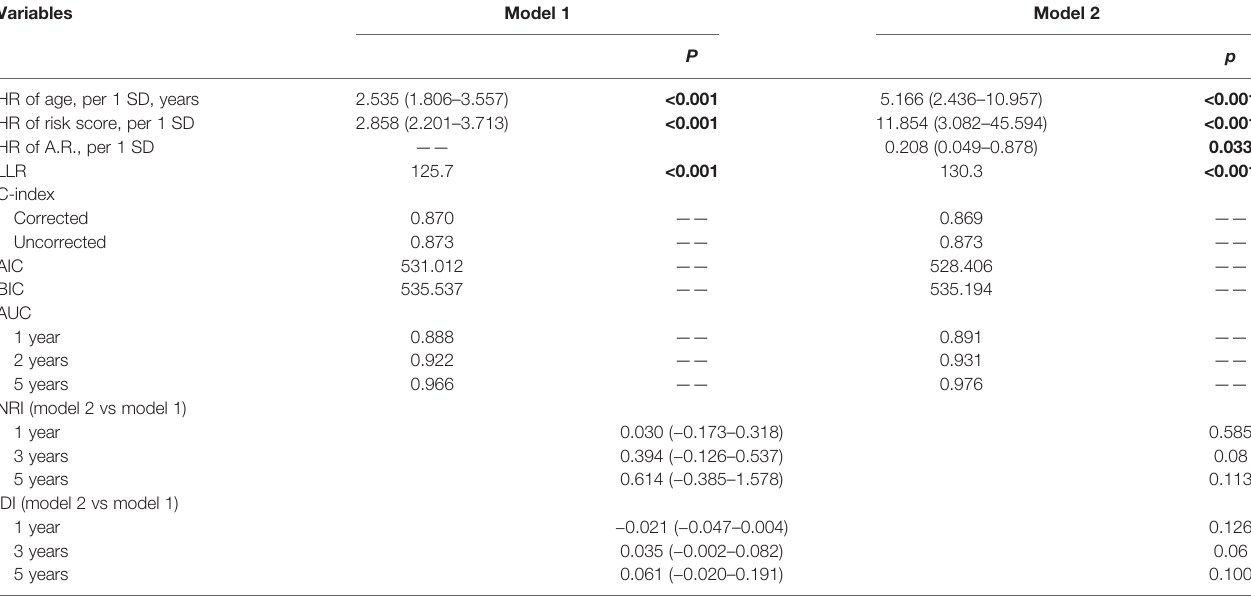
TABLE 3 | The fi ltration of